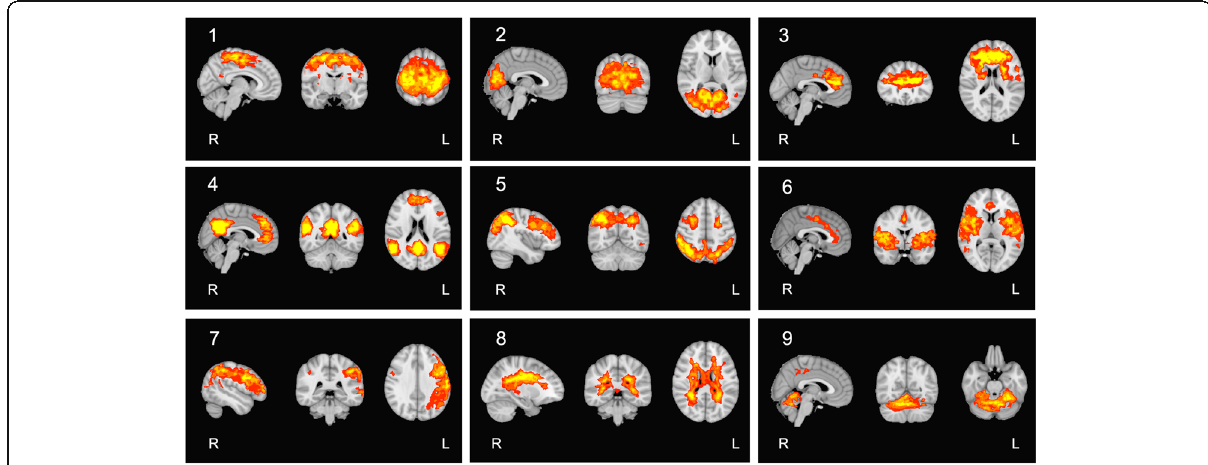
Fig. 2 Group ICA – estimated resting-state networks based on 50-component analysis. Sagittal, axial, and coronal views of the ICA spatial maps estimated by correlation to the known reference network using FSL utility and confirmed by visual inspections, considering 9 nonartifactual